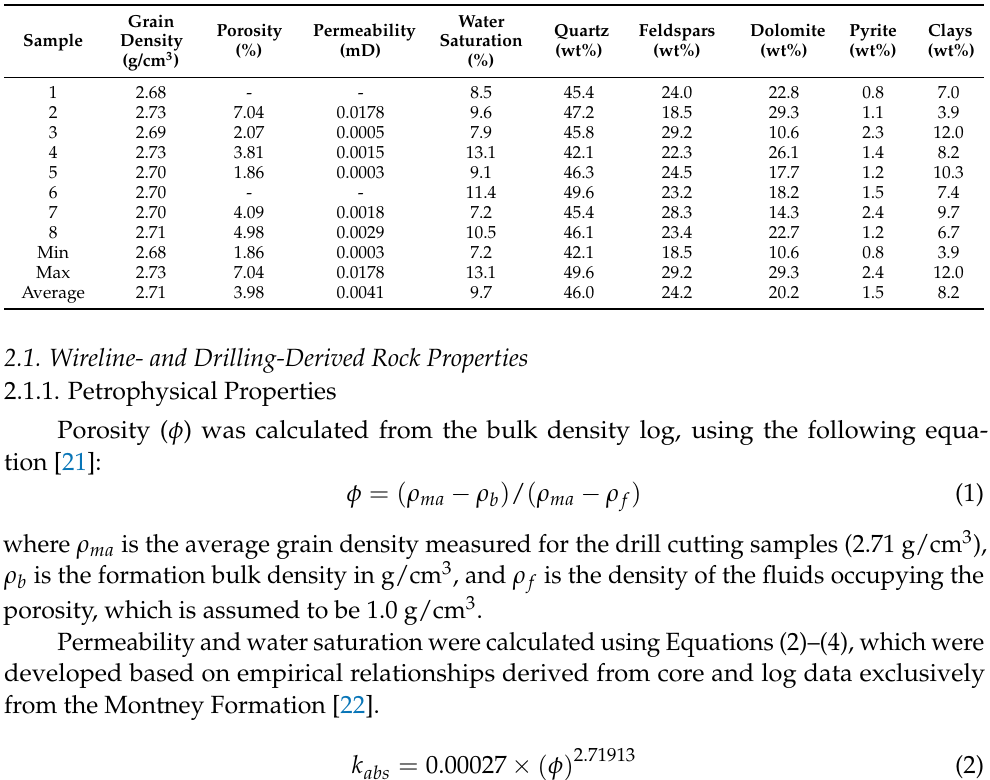
Table 1. Core-measured reservoir properties from the reference Montney vertical well. The data correspond to core plugs collected on an equivalent interval to the landed horizontal well (shaded area in Figure